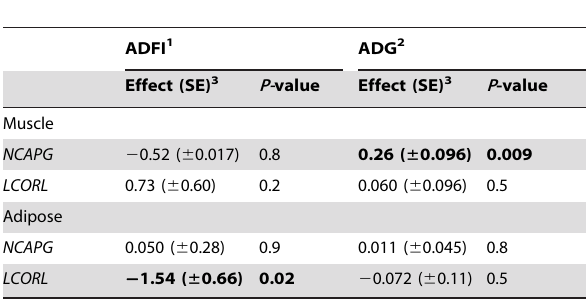
Table 3. Gene expression in the muscle and adipose tissue of cows and their association and estimated effects for ADFI and